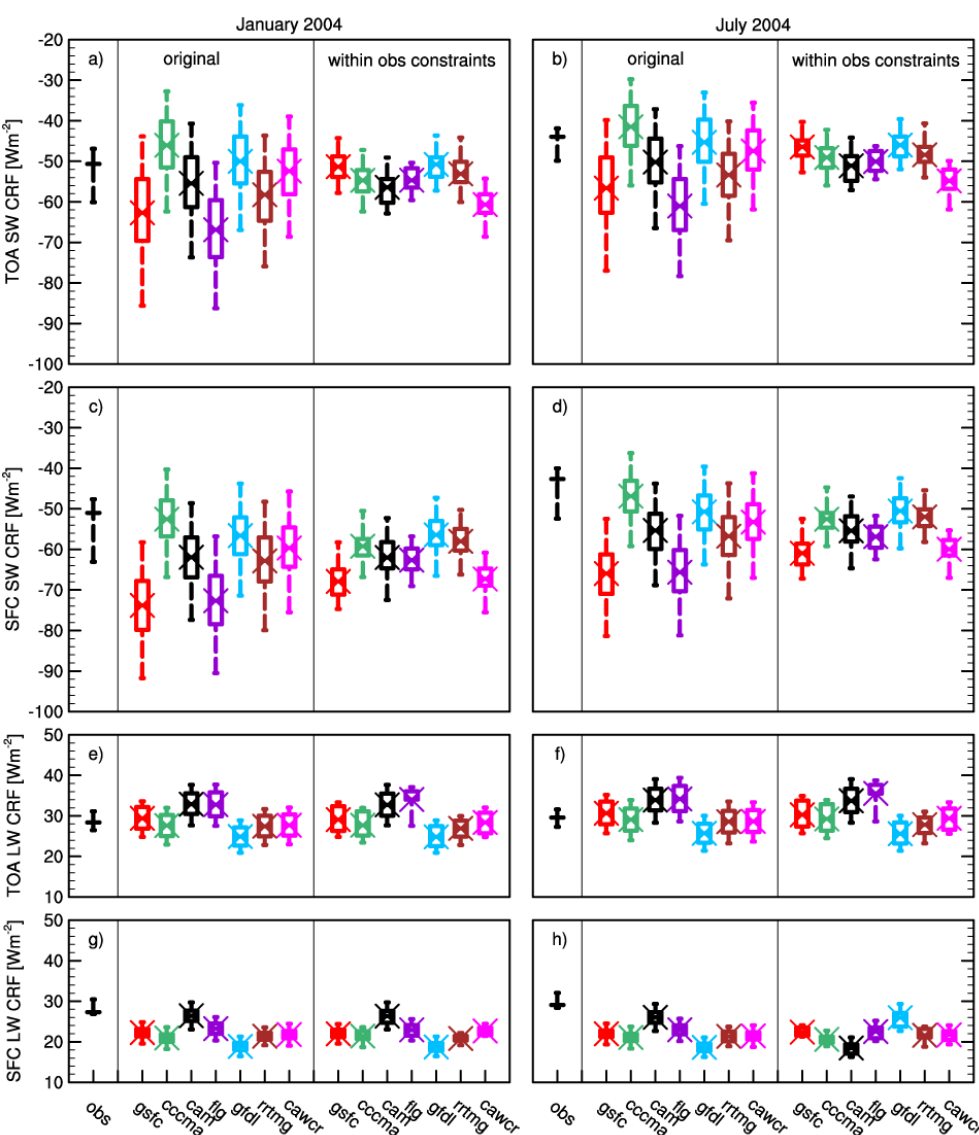
Fig. 7. The SW cloud radiative forcing (CRF) averaged over [60 ◦ S–60 ◦ N] in January (left) and July (right) 2004. Shown are observations (min–max ranges among ISCCP, SRB, CERES, and CERES EBAF), the original results and those with the observational constraints on (NSWT + NLWT), respectively. The box plot illustrates the minimum, 25th percentile, median, 75th percentile, and maximum values among different cloud members for each radiation transfer scheme, while the X within the boxes depicts the ensemble